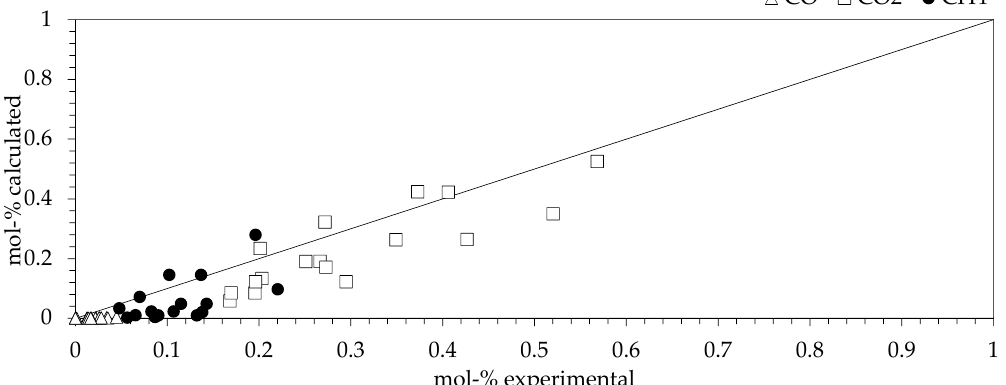
Figure 3. Parity plots of CO (empty triangles), CO 2 (empty cubes) and CH 4 (full spheres) concentrations.